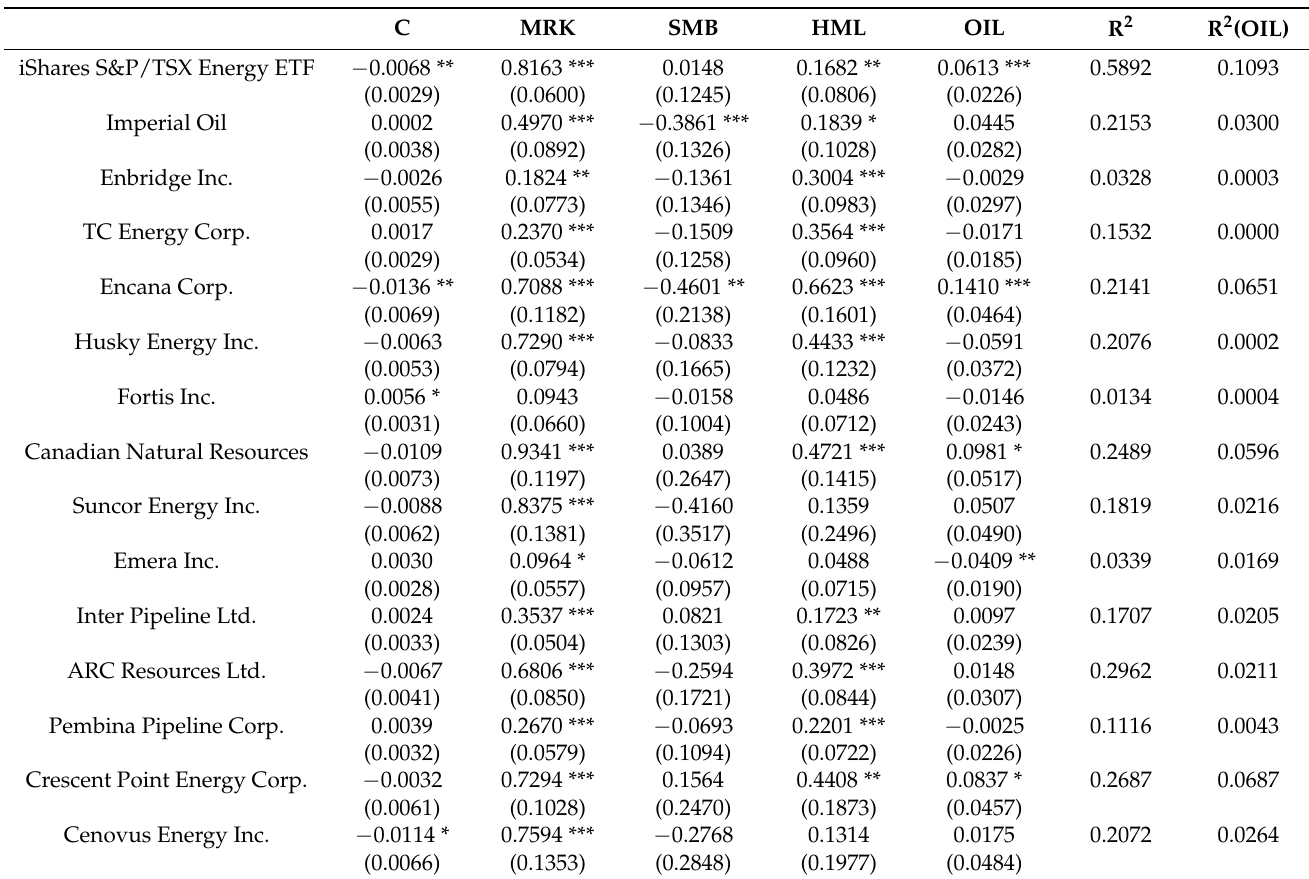
Table 3. Regression results—with